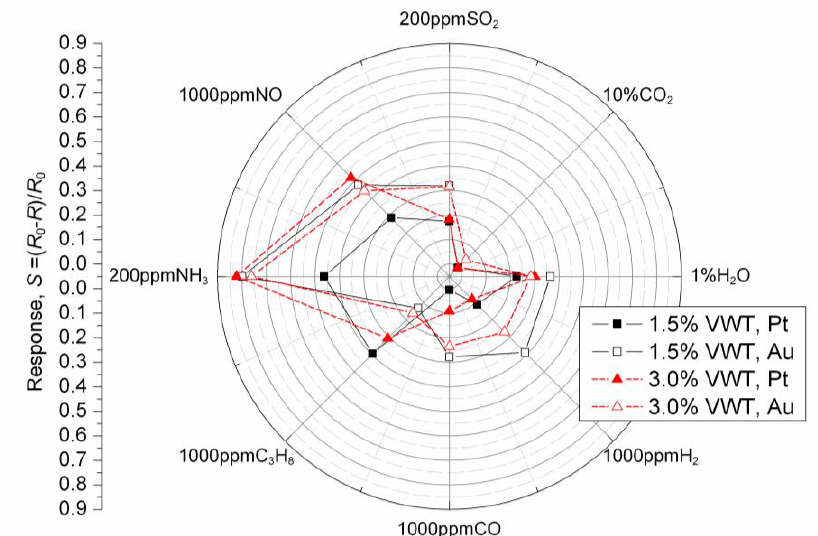
Figure 7. Responses against to the various gases at T = 400